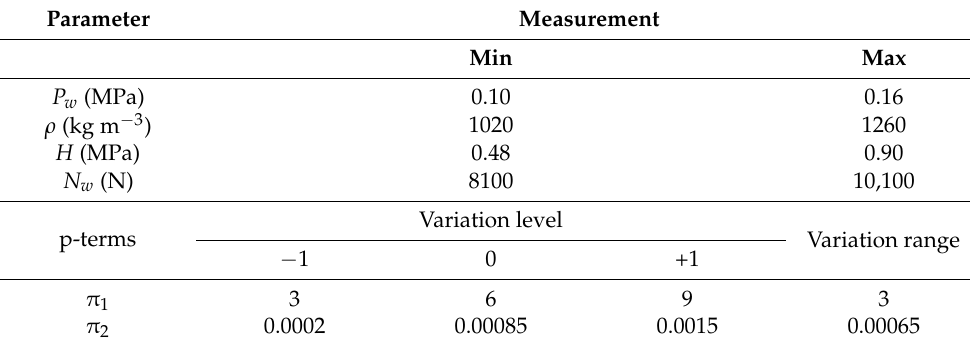
Table 2. Levels and interval variation of parameters and